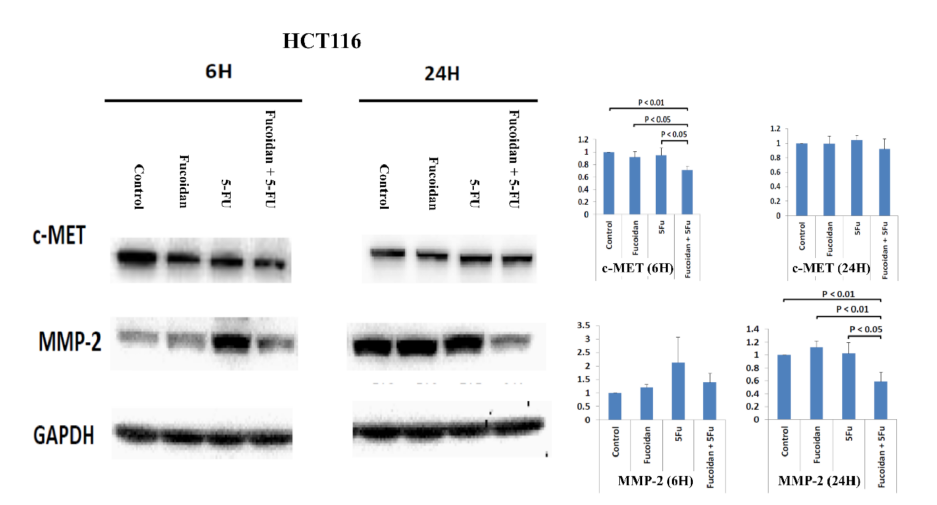
Figure 7. Protein expressions of c-MET and MMP-2 in HCT116 cells after treatment with LMWF, 5-FU, and combination of LMEF and 5-FU.